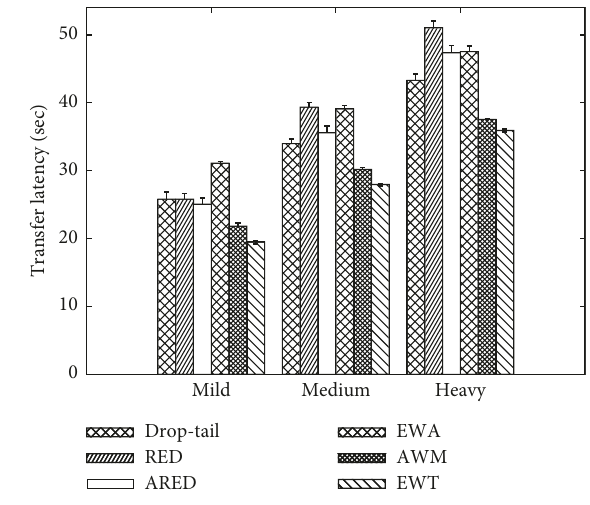
Figure 13: File transfer latency: Scenario 2.